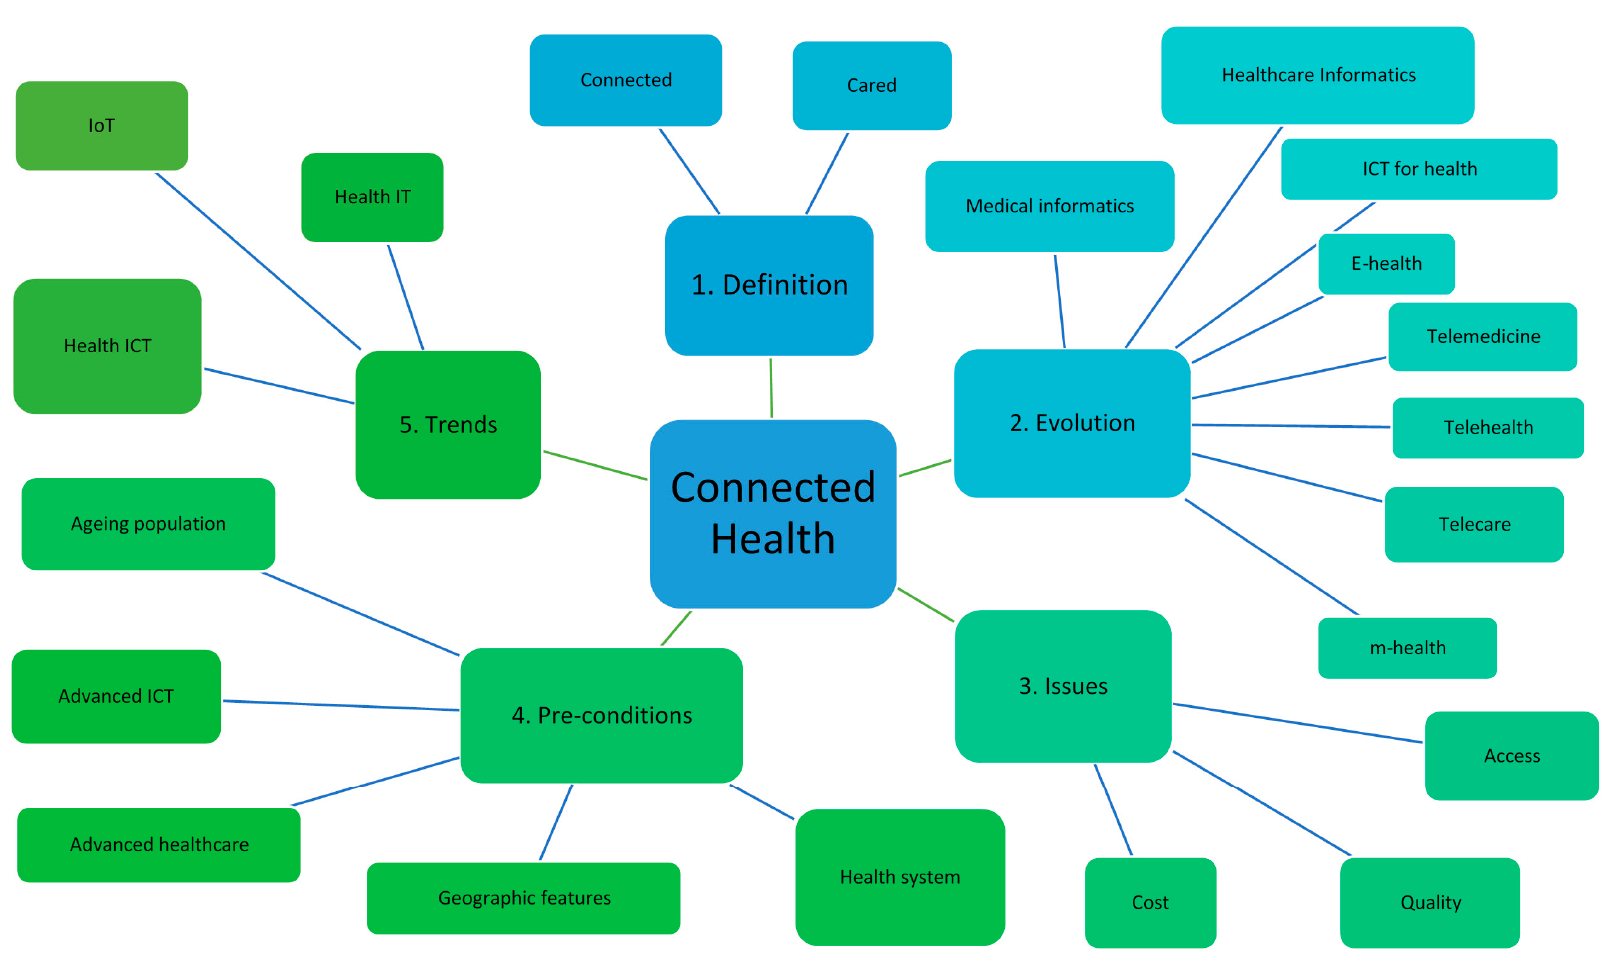
Figure 2. Thematic analysis mapping.